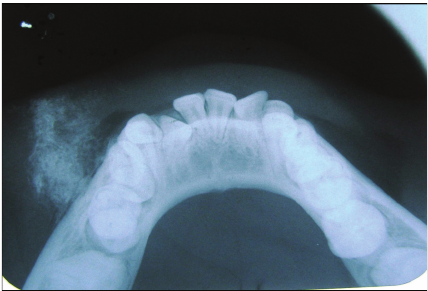
Figure 1: Preoperative occlusal radiograph revealed irregular radiopacitiesextendingintosofttissueshadowofbuccalmucosaand lower lip from the buccal cortex.